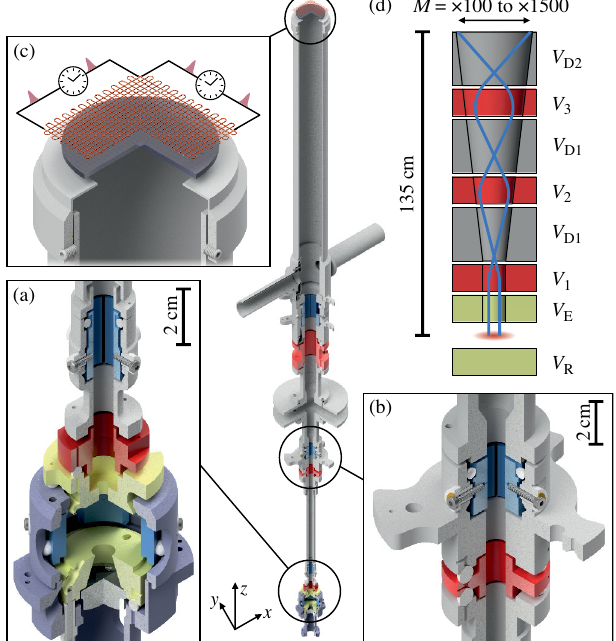
FIG. 2. Ion microscope. The microscope column consists of three electrostatic lenses (main electrodes marked in red, drift sections in gray). Each lens is followed by an electrostatic quadrupole deflector (blue). (a) The object plane lies above a repeller electrode and below an extractor electrode (pale yellow), which, at the same time, are part of a six-plate electric field control (radial field plates marked in blue). The repeller hosts an indium-tin-oxide-coated aspheric optical lens. The extractor also acts as the lower lens electrode of the firstlens. (b) Detailed view of the second lens and the following deflection stage. (c) Spatially resolved ion detection is achieved via a delay-line anode on top of an MCP stack. (d) Schematic representation of the electrode configuration. Imaging properties and magnification are deter- mined by the extraction voltages ( V and V ), the lens voltages E R ( V 1 to V 3 ), and the drift-tubevoltages ( V and V ). The latter are D 1 D 2 ¼ V referred to as V for all measurements for which V D D 1 D 2